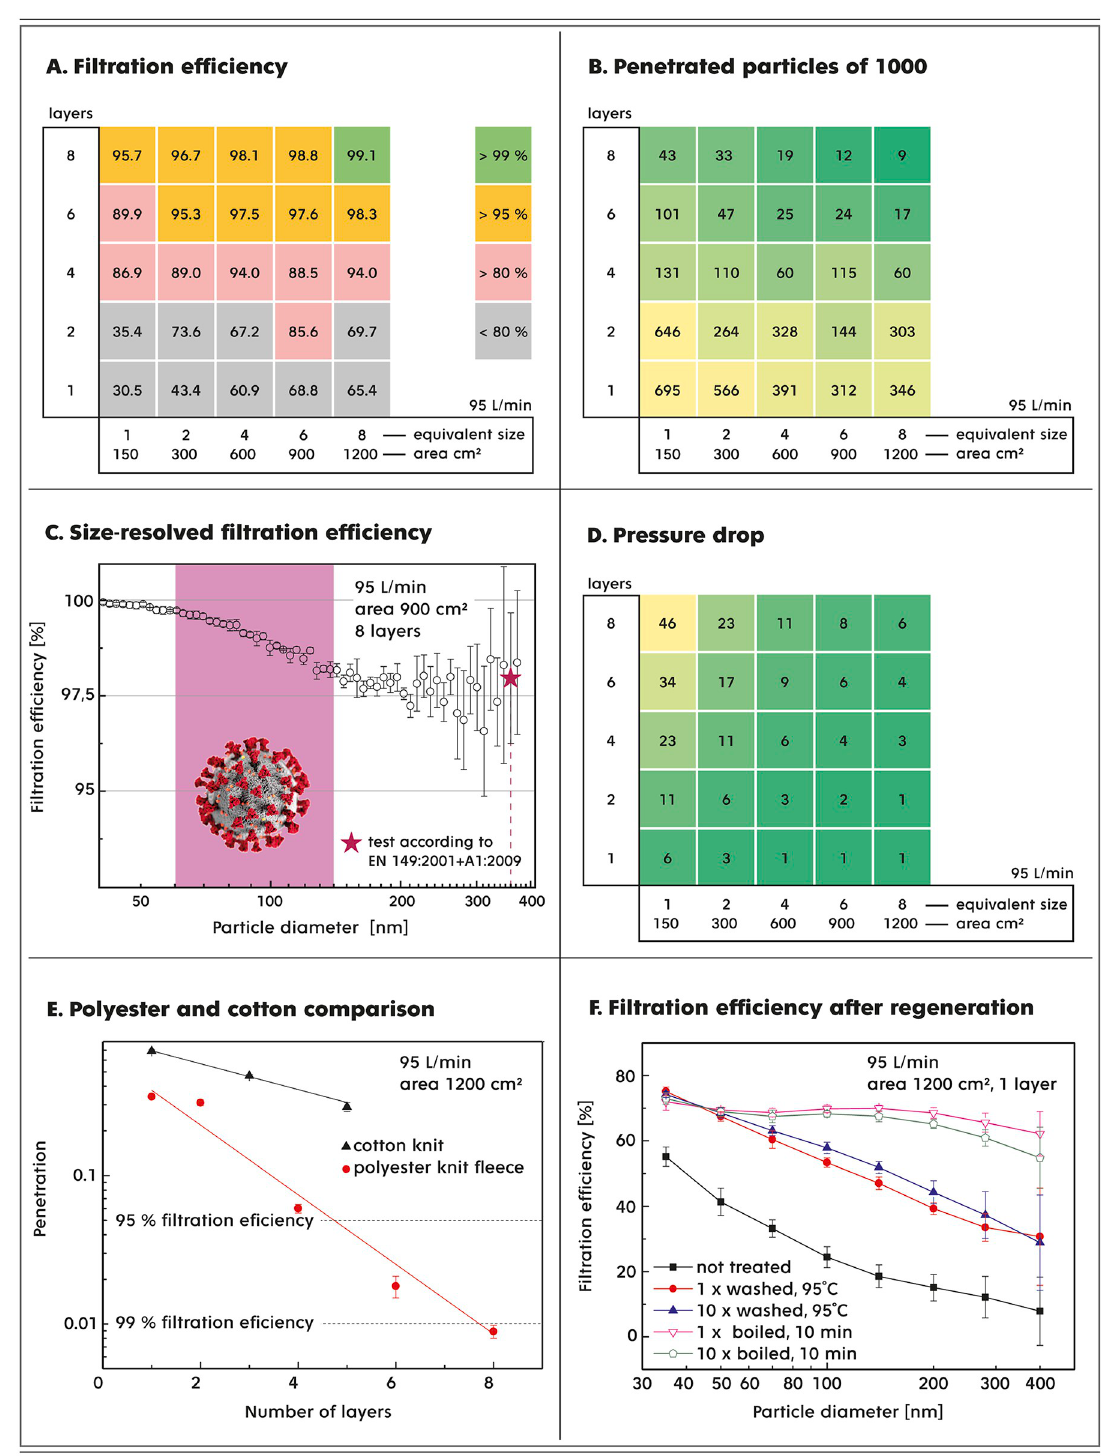
Fig 2. Characteristics of the knit PES fleece fabric used as a filter material. Panels A, B and D show the filtration ability of the PES fabric depending on the filter area, which was varied as multiples of the area of 150 cm 2 (the size of the mask) and the number of layers of filter material. One layer has a thickness of 2.3 mm. The volumetric flow rate was selected to be 95 L/min. Panel A shows the filtration efficiency for 100 nm particles, Panel B represents the number of particles out of 1,000 that pass through the filter cartridge, and Panel D shows the corresponding pressure drop (Pa) evaluated on the basis of the measured permeability. Panel C shows the experimental curve of the filtration efficiency as a function of the particle diameter for a filter six times the size of a standard mask with eight layers of PES